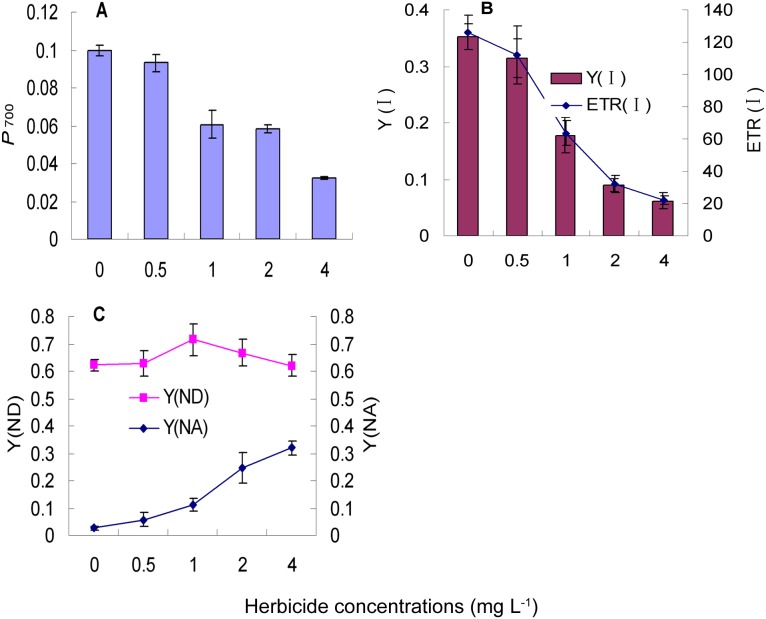
Effect of nicosulfuron on P700 parameters in leaves of Radix Isatidis seedlings.Values represent the means and vertical bars indicate the standard deviation of three separate experiments. P
m, Y(I), ETR (I), Y(ND) and Y(NA) represent maximal P
700 change, photochemical quantum yield of PS I, PS I electron transport rate, quantum yield of non-photochemical energy dissipation due to donor side limitation in PS I, and quantum yield of non-photochemical energy dissipation due to acceptor side limitation in PS I. The abscissa in the figure represents the concentration of nicosulfuron and the unit is “mg L−1”.